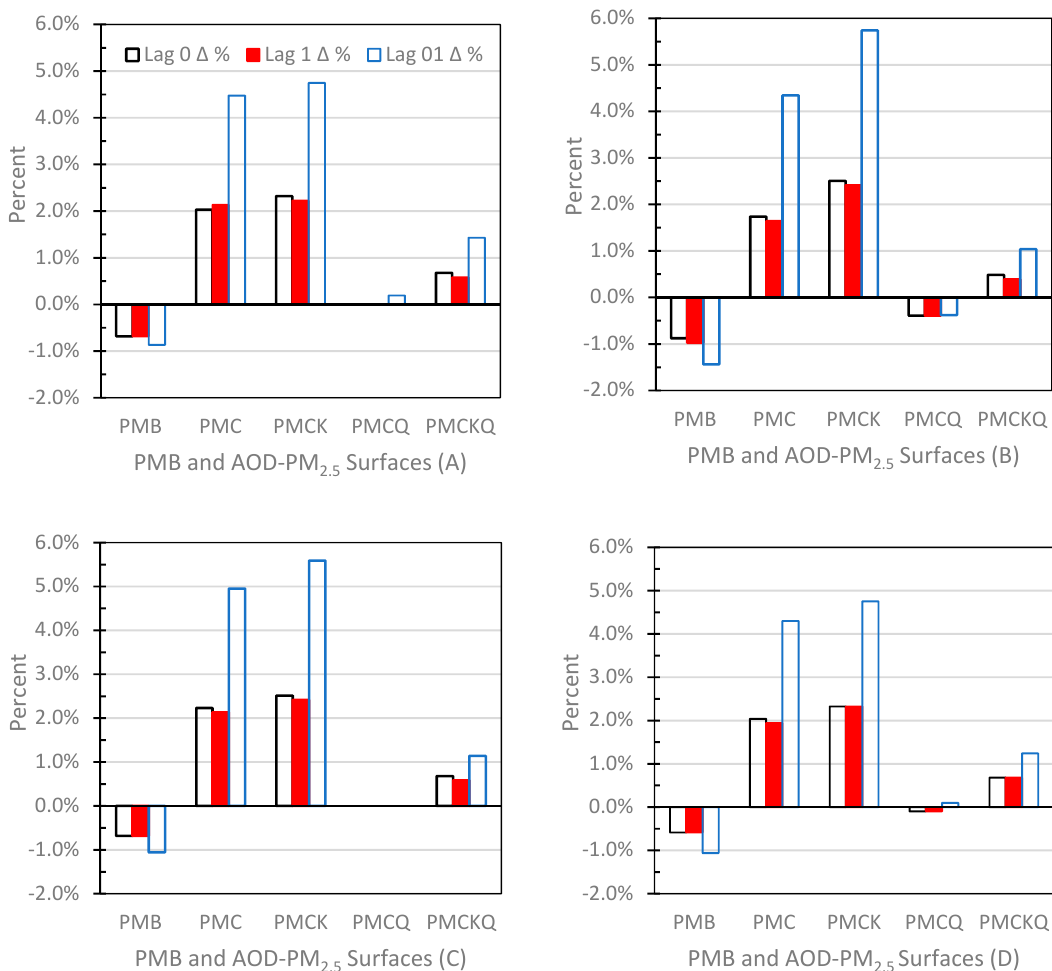
Figure 5. Percent change between no monitor and monitor Odds Ratios (ORs) for the four experimental AOD-PM 2.5 concentration surfaces and PMB at lag days of 0, 1 and 01: ( A ) ED asthma (top left panel), ( B ) IP asthma (top right panel), ( C ) IP MI (bottom left panel), and ( D ) IP HF (bottom right panel).